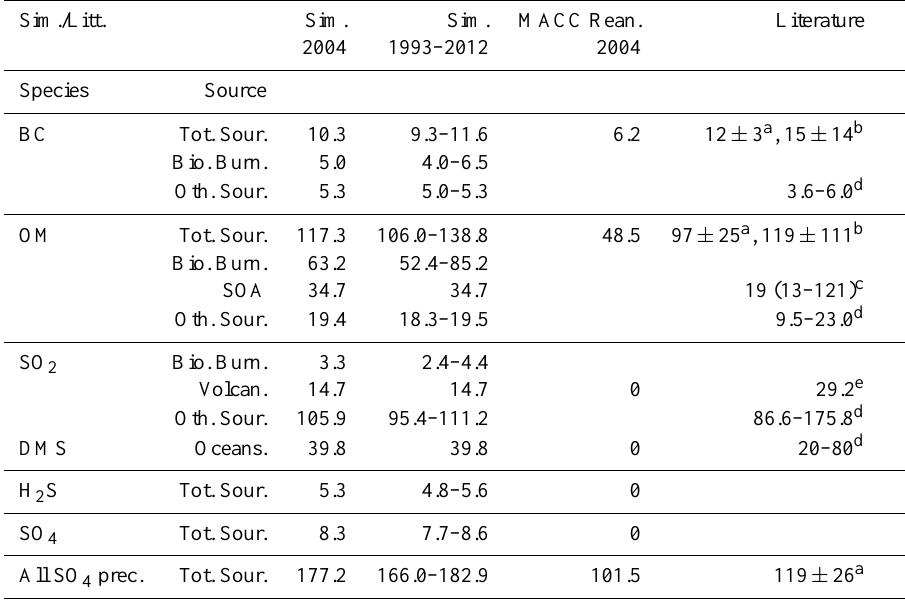
Table 2. Prescribed emission totals, including those used for the 2004 simulations, the 2003–2012 transient simulations, the MACC Reanal- ysis, and totals reported in the